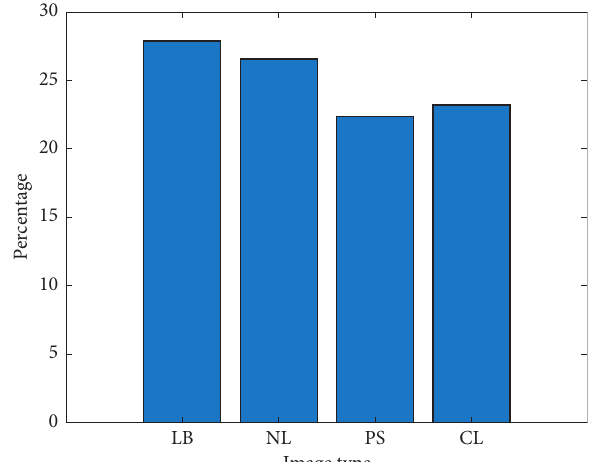
Figure 3: Image type